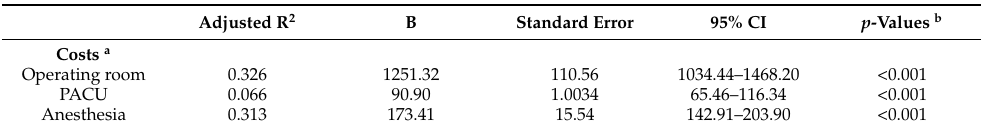
Table 3. Adjusted Regression Models for Operating Room, PACU, and Anesthesia Cost by Use of General Anesthesia.